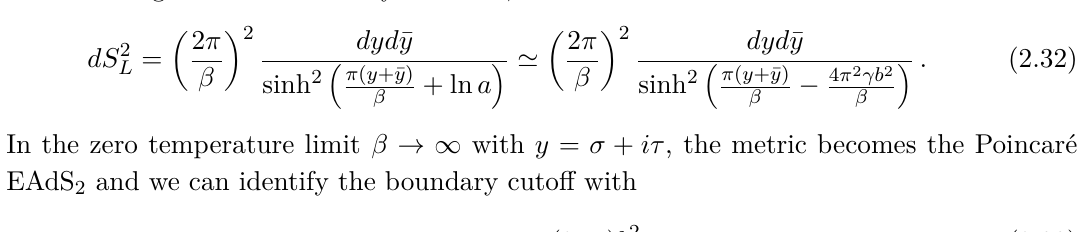
Table 3 . The correspondence between the (rescaled) parameters of the two descriptions. 2 πy Transforming the coordinates by z = e β , the metric becomes a cutoff EAdS 2 black